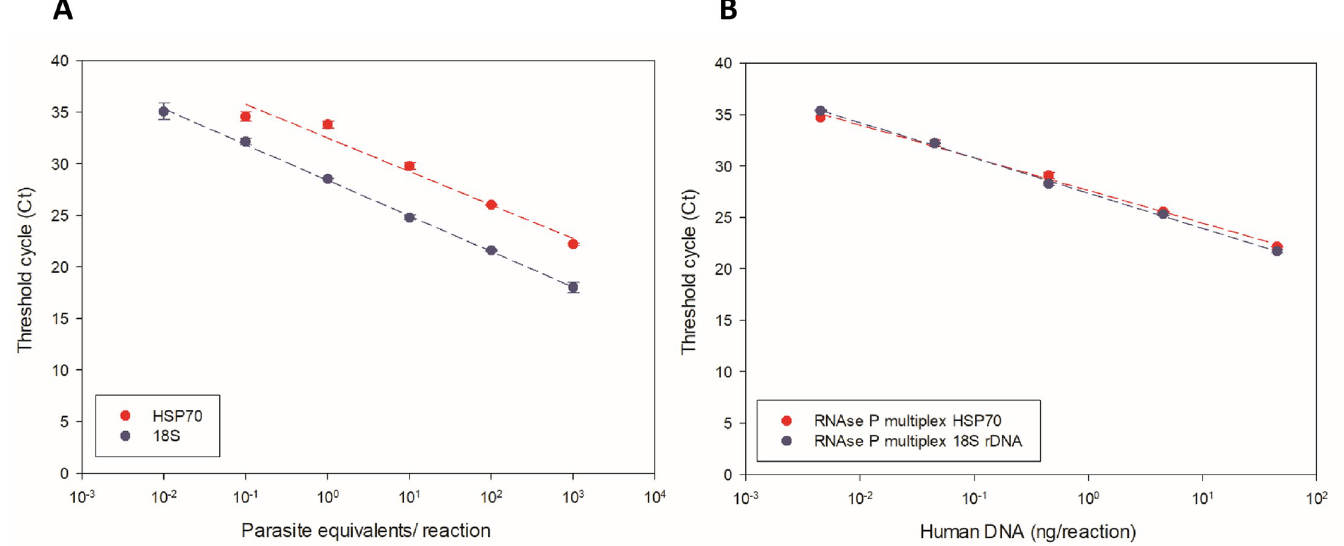
Fig 2. Dynamic extension of L . (V . ) braziliensis detection. (A) Standard curve for the targets 18S rDNA and HSP70. (B) Standard curve for the targets 18S rDNA and HSP70 in multiplex with RNAse P internal control. Serial dilutions of human DNA mixed with parasite DNA in a 1:9 proportion were assayed for all curves.